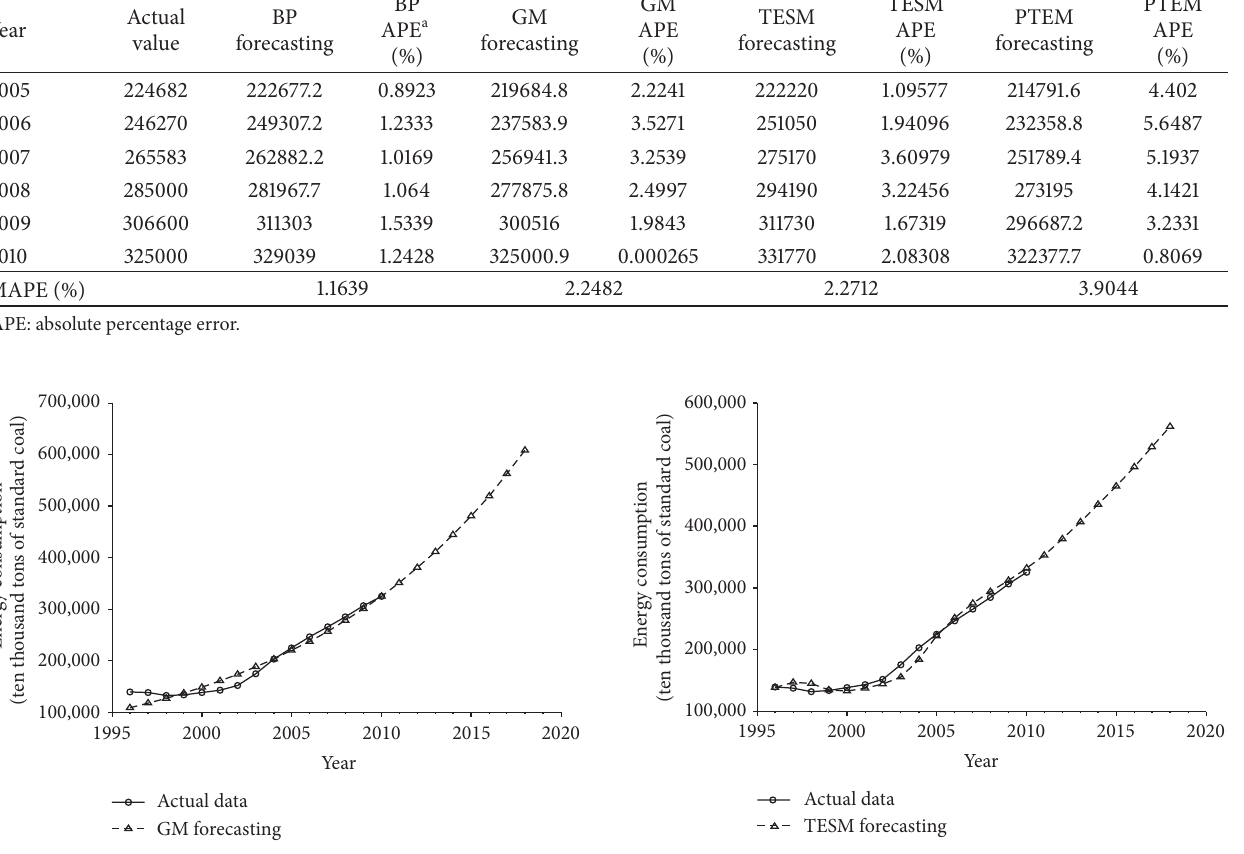
Figure 5: Forecast of China’s energy consumption by TESM.